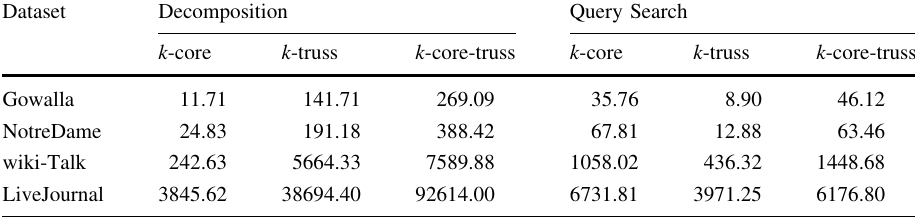
Table 3 Running time of graph decomposition and query processing in three different models: k -core, k -truss and k - core-truss (in seconds)